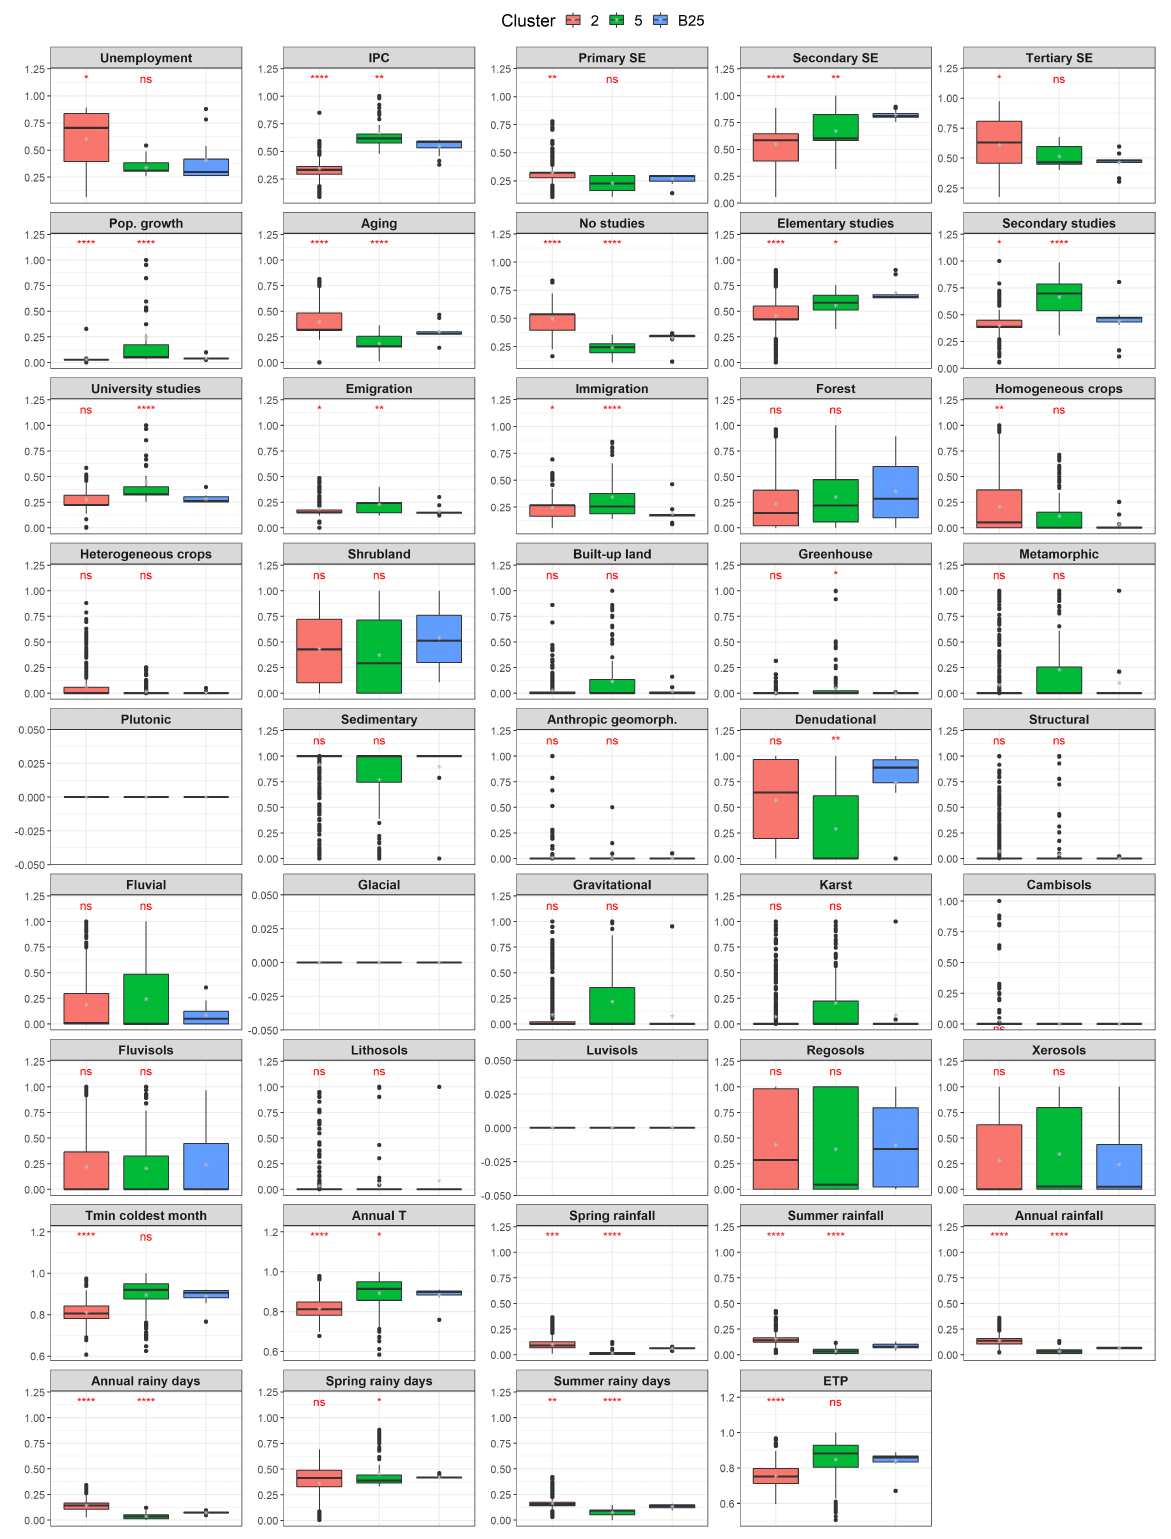
Figure A3. Comparison of the socio-ecological variables between Sectors 2 and 5 and the boundary between them (B25). Statistical significance is shown as: ns: p -value > 0.05; *: p -value ≤ 0.05; **: p -value ≤ 0.01; ***: p -value ≤ 0.001; ****: p -value ≤